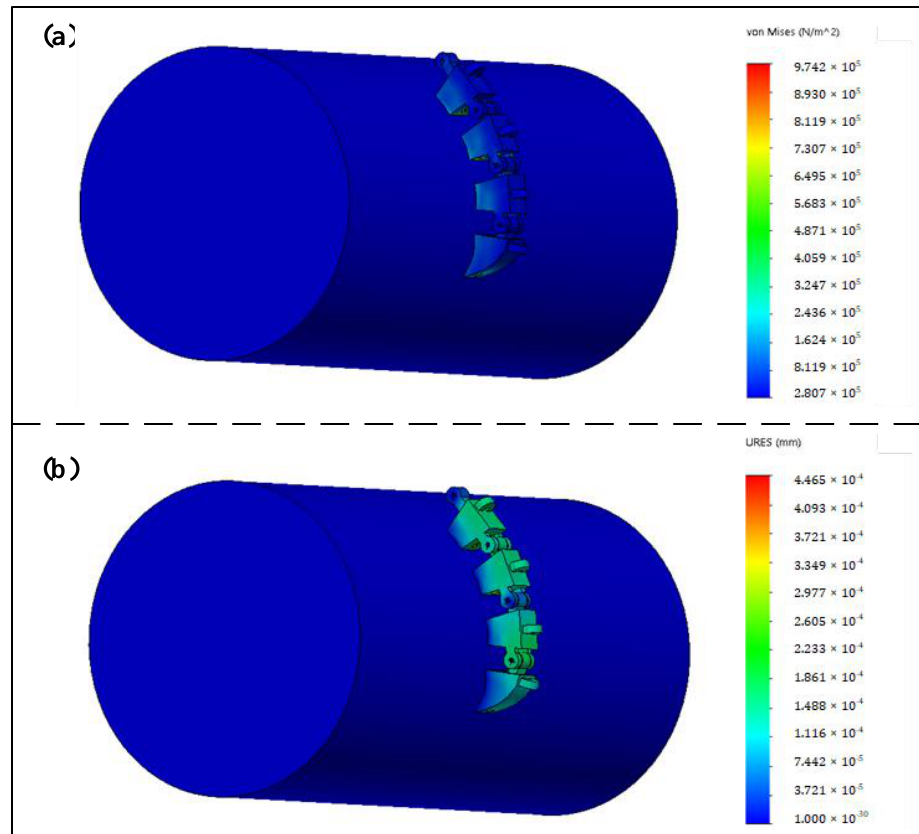
Figure 6. Finite element analysis of claw toe. ( a ) Stress results. ( b ) Displacement results.